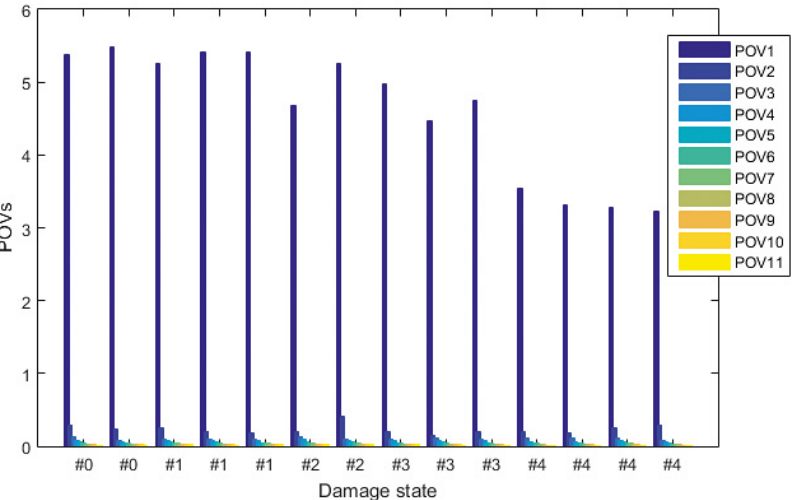
Figure 4. Proper orthogonal values (POV) of all damage states